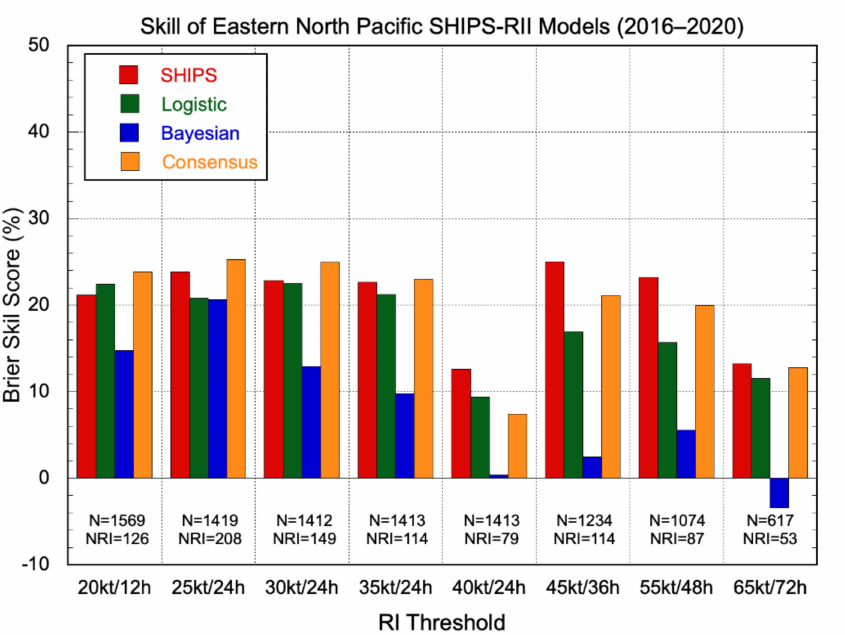
Figure 8. Brier skill scores for 2016–2020 eastern North Pacific basin real-time SHIPS-RII-LDA (red), SHIPS-RII-LR (green), SHIPS-RII-B (blue), and SHIPS-RII-C (orange) model forecasts relative to climatology. The different RI thresholds are listed below each bar grouping along with the total number of cases and the number of those cases for which RI occurred. Negative scores depict thresholds for which the model had less skill than